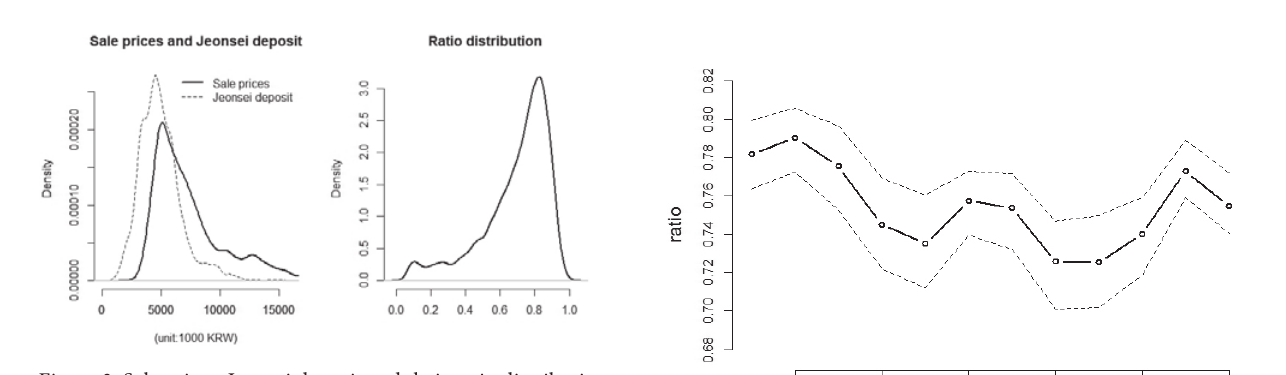
Figure 3. Sale prices, Jeonsei deposit and their ratio distribution